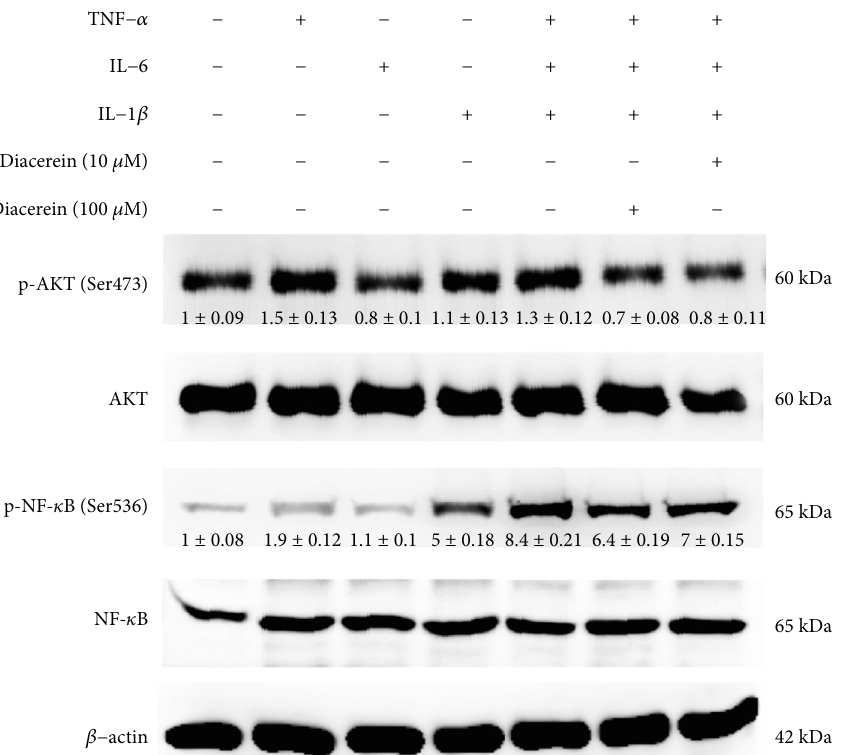
Figure 6: Diacerein inhibits cytokine-induced in fl ammation through attenuating AKT and NF- κ B phosphorylation in ARPE-19 cells. TNF- α , IL-6, and IL-1 β facilitated an increase in AKT and NF- κ B phosphorylation levels in treated ARPE-19 cells compared to control cells. The phosphorylation level of AKT and NF- κ B determined by western blotting. β -Actin was used as a reference control. Full-length blots are presented in Supplementary Figure 2. Quanti fi cation of protein expression levels by normalization to the internal control β -actin. Depicted western blots are one representative fi gure of three independent experiments. Results are the mean ± SD of three independent